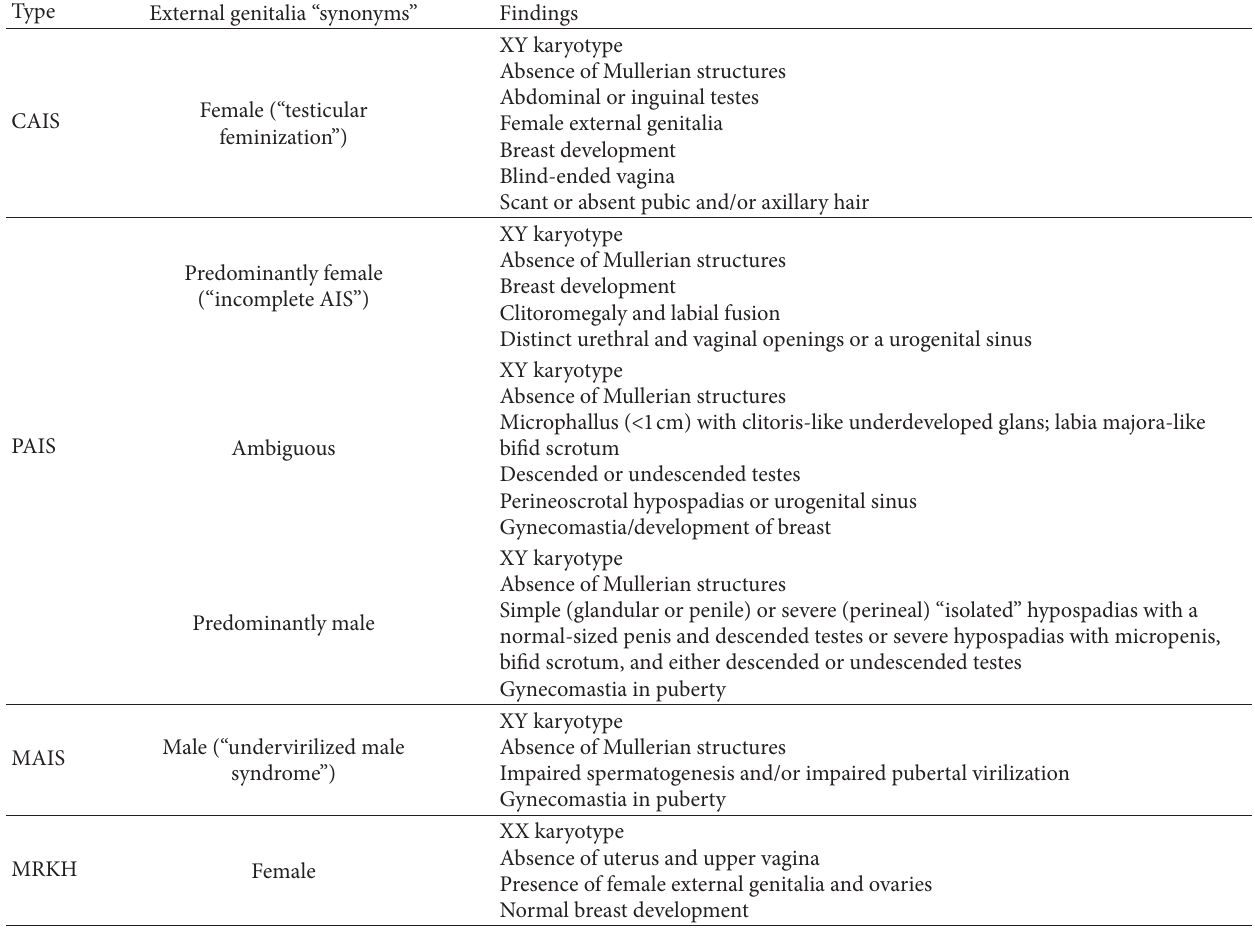
Table 2: Differential diagnosis for complete androgen insensitivity syndrome (CAIS). Adapted from Gottlieb et al. [6].